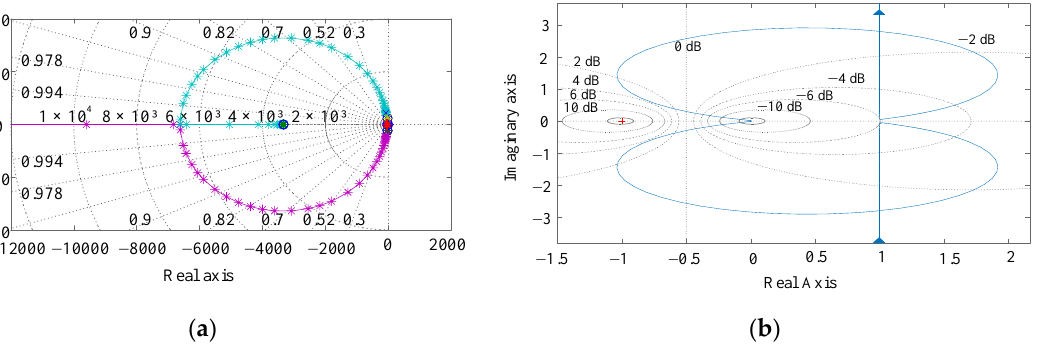
Figure 9. The ( a ) root locus and ( b ) Nyquist plot of the proposed control system in the bipolar DC distribution network.